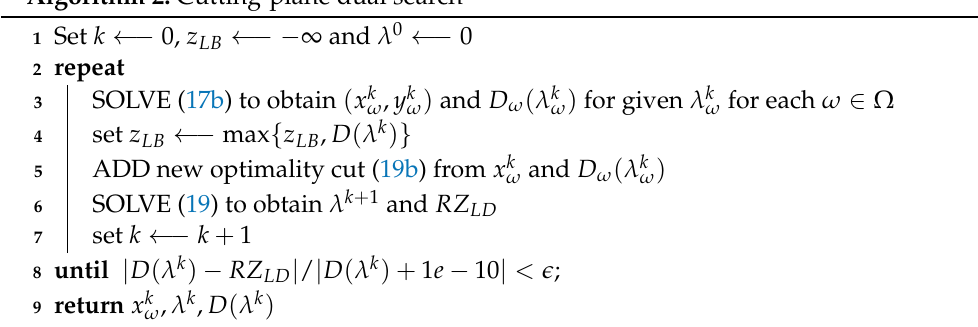
Algorithm 2: Cutting-plane dual